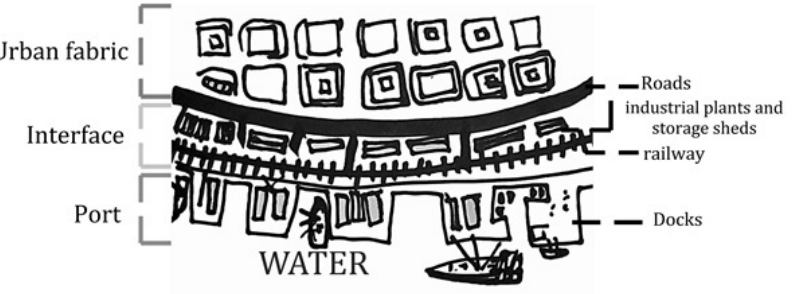
Figure 1. Illustrative diagram of the spatial split between city and port, with the separating interface as buffer zone. Source: Amended by the authors, based on Wrenn